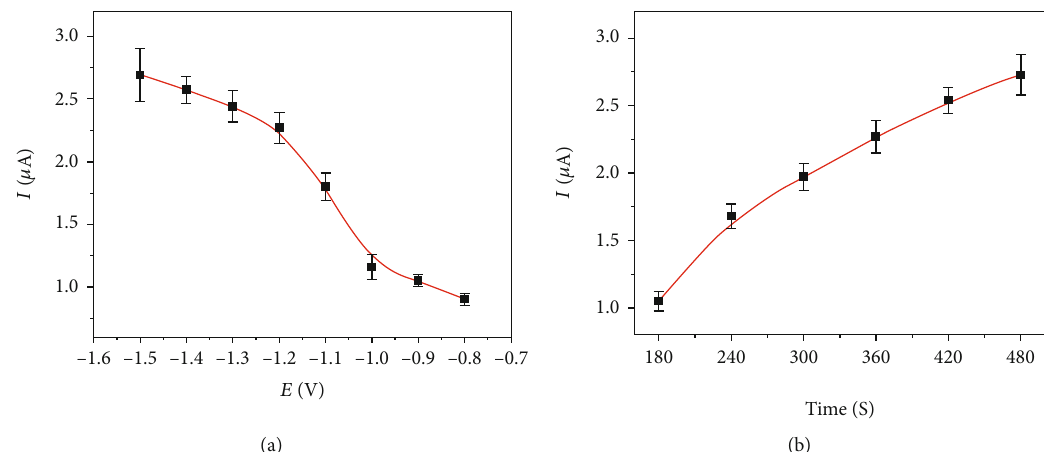
Figure 6: E ff ect of deposition potential (a) and deposition time (b) of 4.5 μ g · L -1 Pb 2+ detection in acetate bu ff er (pH4.5) on p(1,5- DAN)/SPEs.